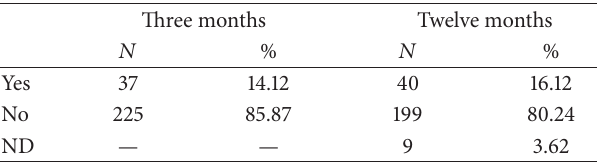
Table 9: “Forgotten, by choice or by accident, a few injections in the last 4 weeks?” ( ∗ ).